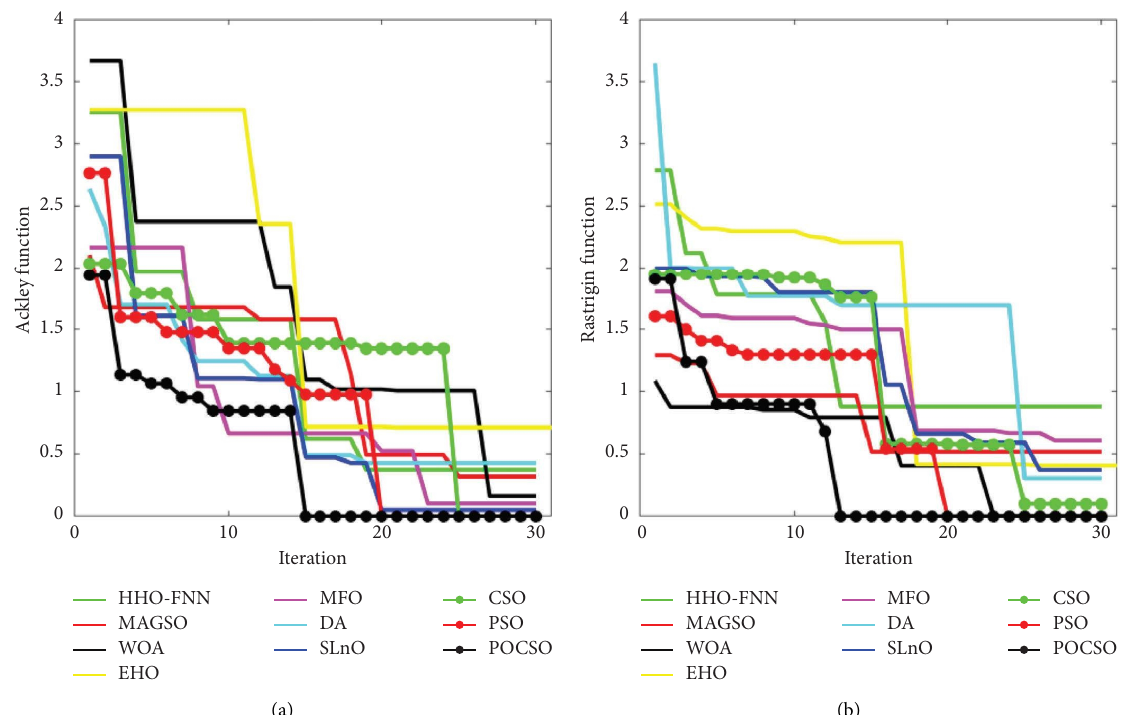
Figure 10: Convergence analysis of the proposed POCSO and extant methods for multimodal benchmark functions such as (a) ackley and (b) rastrigin.